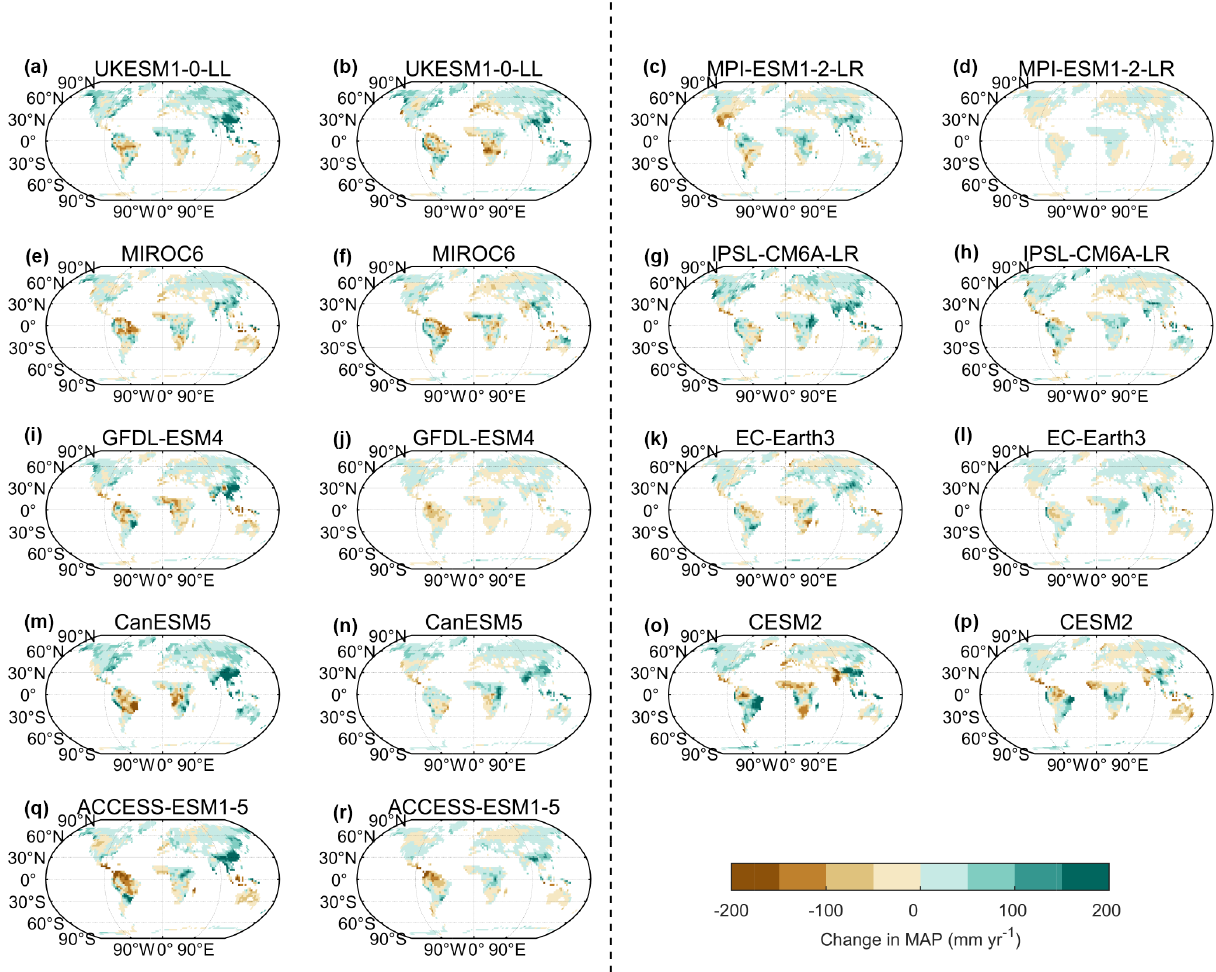
Figure 10. The spatial pattern of change in MAP between the period of 2015–2044 and 2071–2100 from (a) UKESM1-0-LL and (b) em- ulation from PREMU under SSP1–2.6 scenario. (c, d) MPI-ESM1-2-LR; (e, f) MIROC6; (g, h) IPSL-CM6A-LR; (i, j) GFDL-ESM4; (k, l) EC-Earth3; (m, n) CanESM5; (o, p) CESM2; (q, r)